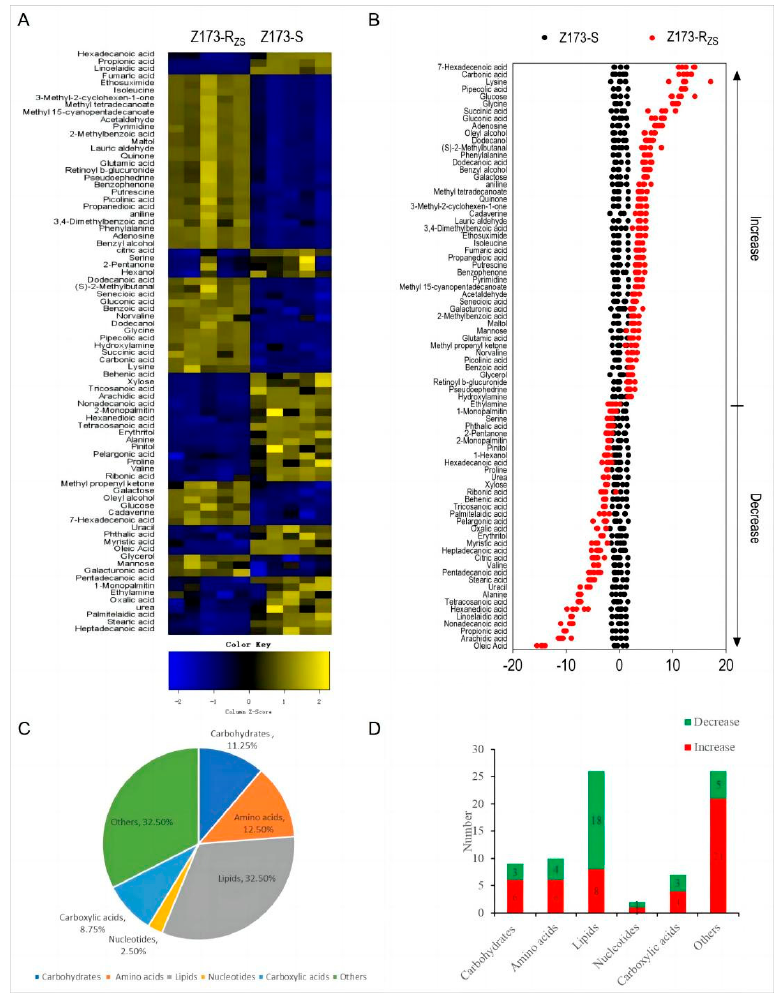
Figure 2. Identification of differential metabolites in Z173-S and Z173-R ZS . ( A ) Heat map of unsupervised hierarchical clustering of varied abundance of metabolites. Yellow and blue indicate increase and decrease of metabolites relative to the median metabolite level, respectively (see color scale). ( B ) Z-score plots. Each point represents one metabolite in one technique repeat. Black and red represent Z173-S and Z173-R ZS , respectively. ( C ) Category of varied abundance of metabolites. ( D ) Number of metabolites increased and decreased in six